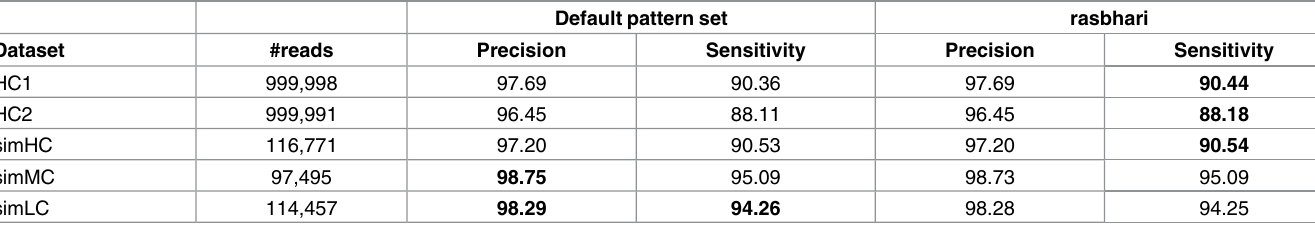
Table 2. Read classification with CLARK-S using different pattern